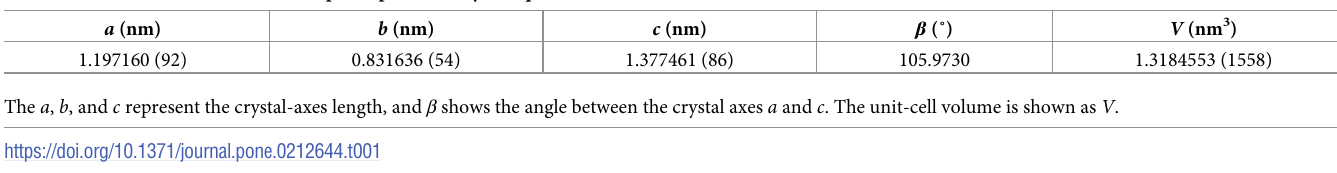
Table 1. Lattice constants of the siderophore produced by C . cupreum .